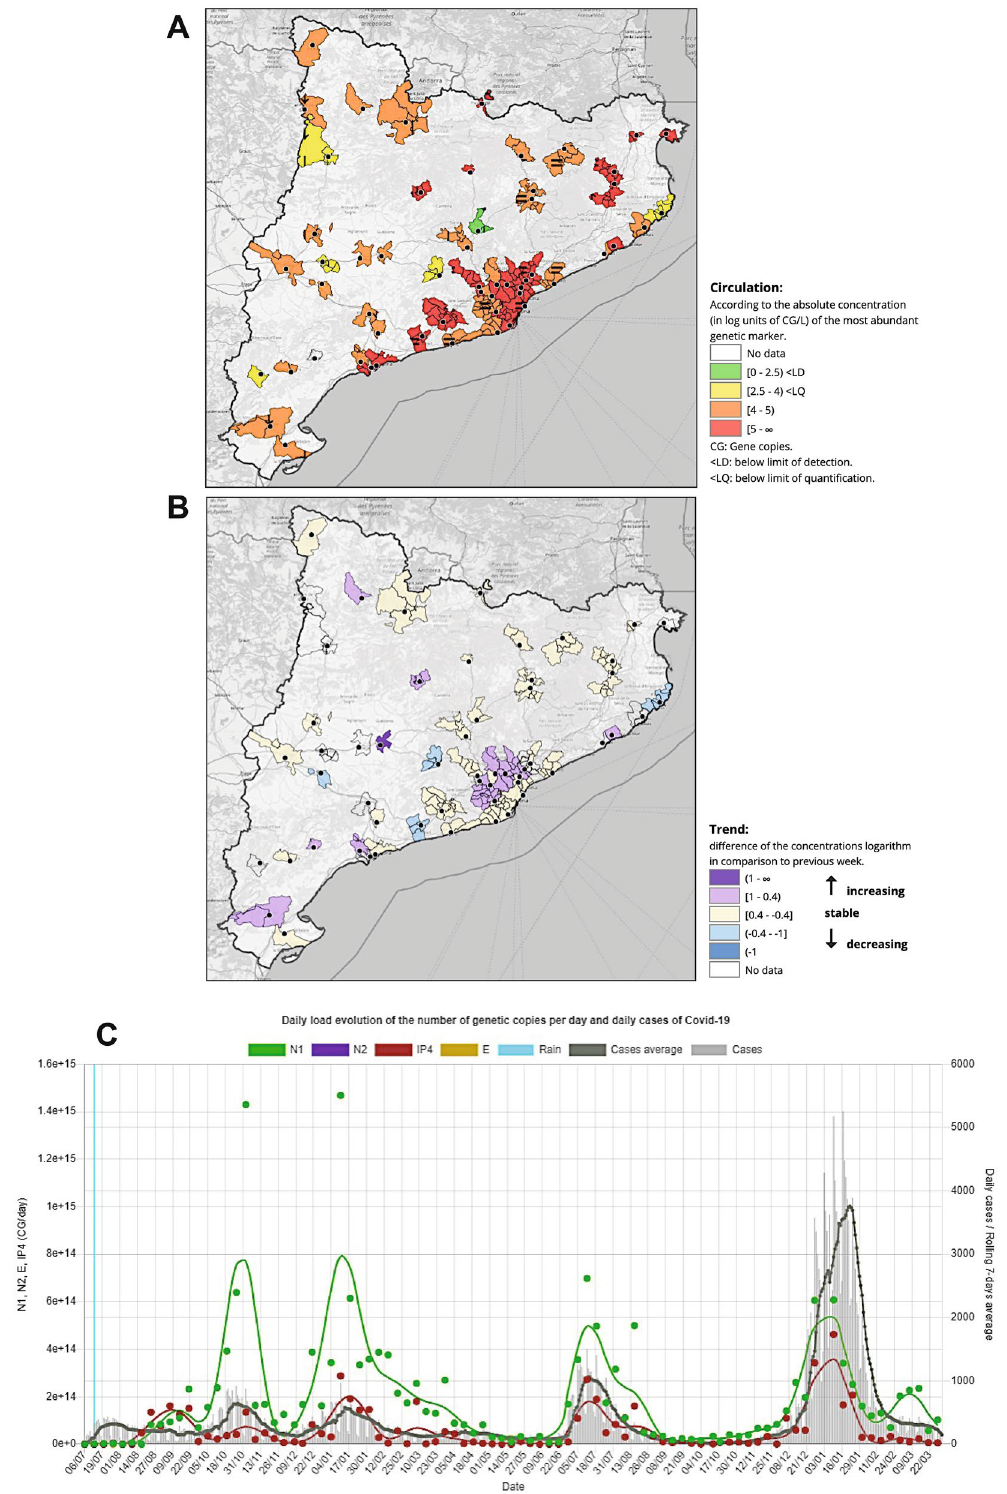
Figure 2. Images retrieved from the SARSAIGUA dashboard showing ( A ) the absolute abundance of SARS- COV-2 (in GC/L) at the monitored WWTP, and ( B ) weekly trends calculated at each monitored WWTP. For each WWTP, the temporal dynamics of its viral load and reported clinical cases in the assisted municipalities can also be displayed ( C ). Maps in the online dashboard were obtained from OpenStreetMap (https:// www. opens treet map.